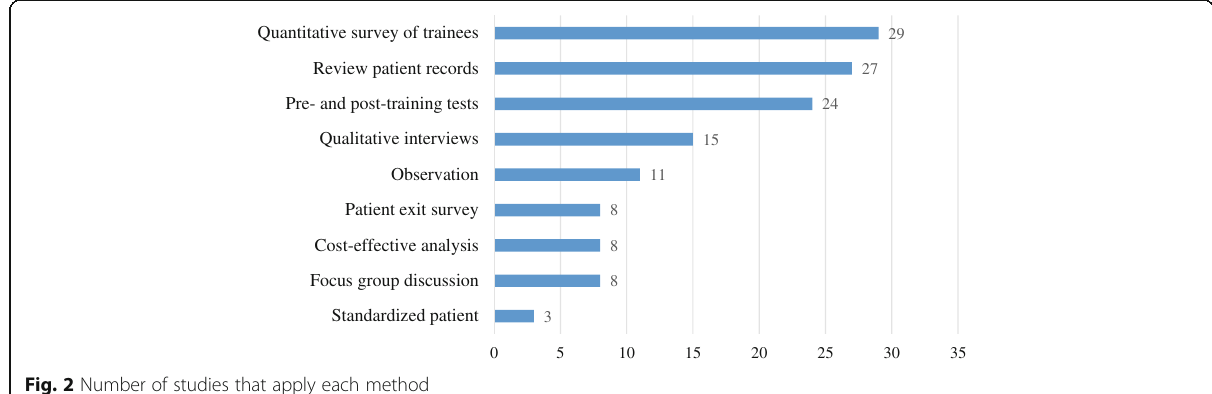
Fig. 2 Number of studies that apply each